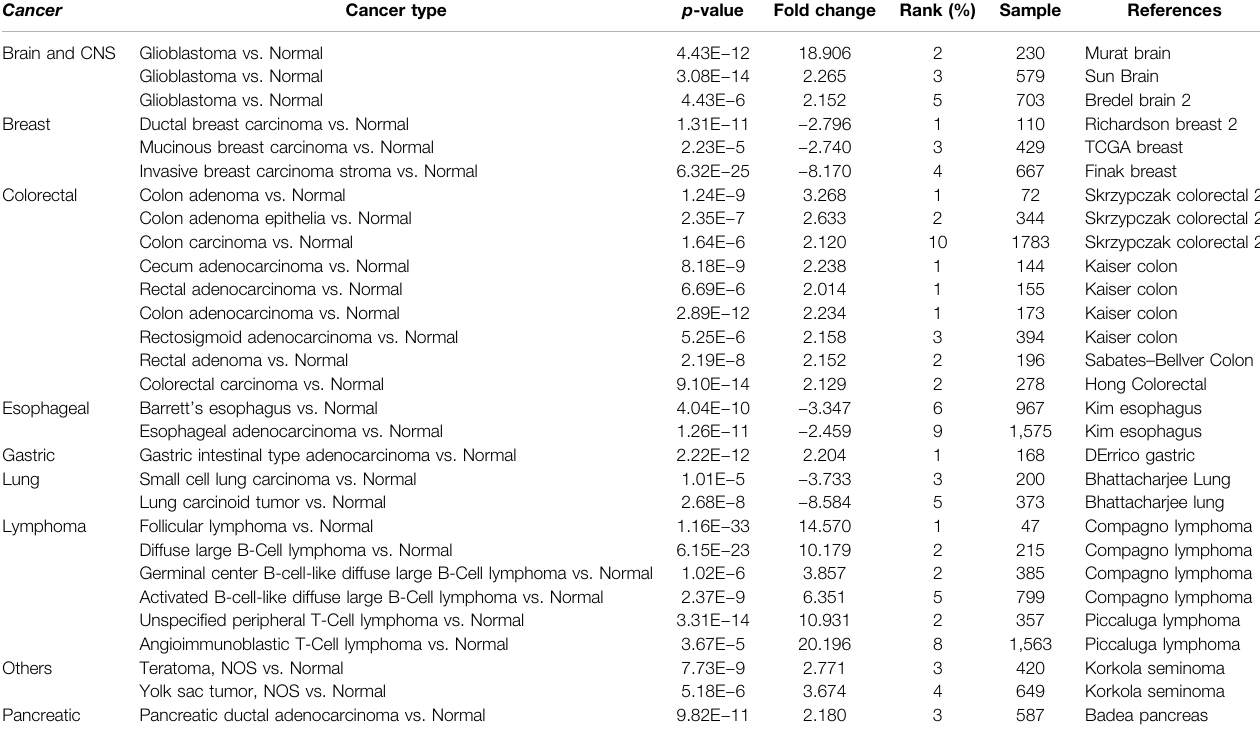
TABLE 1 | Differences in YAP1 expression between cancer tissues and normal tissues based on the Oncomine database. Cancer